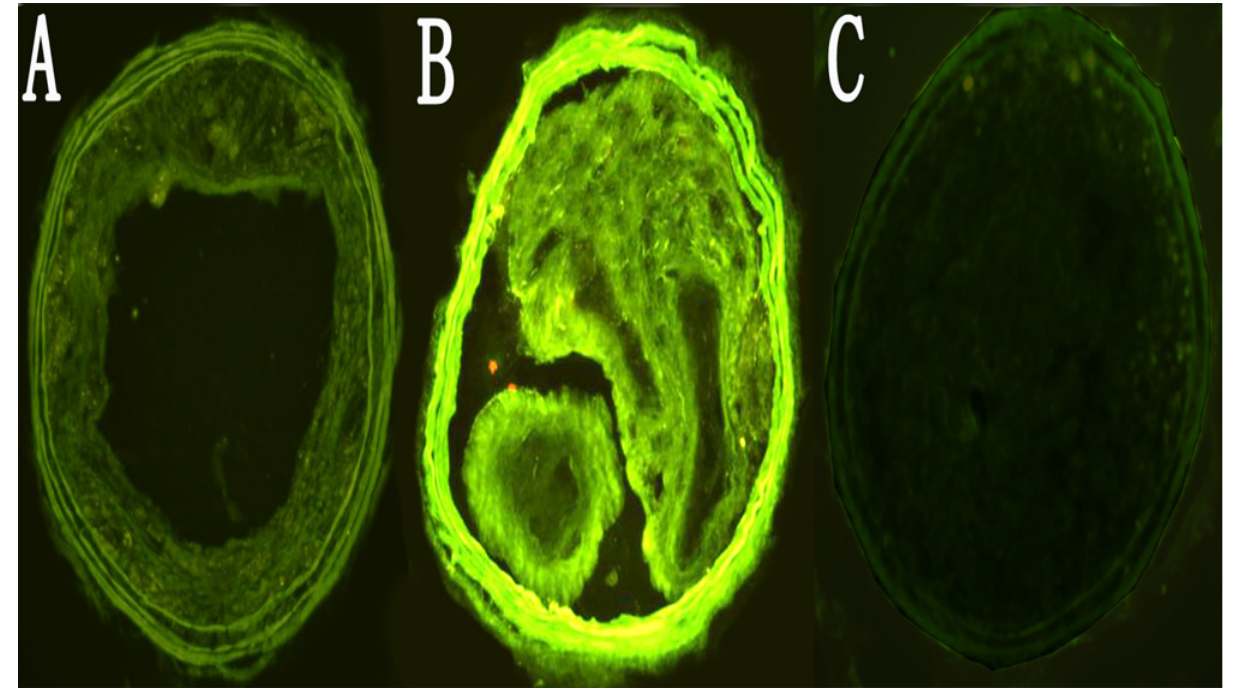
Fig 3. Efficiency of lentviral shRNA vector transduction in the carotid plaques. A, B, C. GFP expression in sections of the carotid plaques was imaged from NC group. Carotid plaques at 1, 2 and 4 weeks following transduction were visualized under fluorescent microscope. (200×).